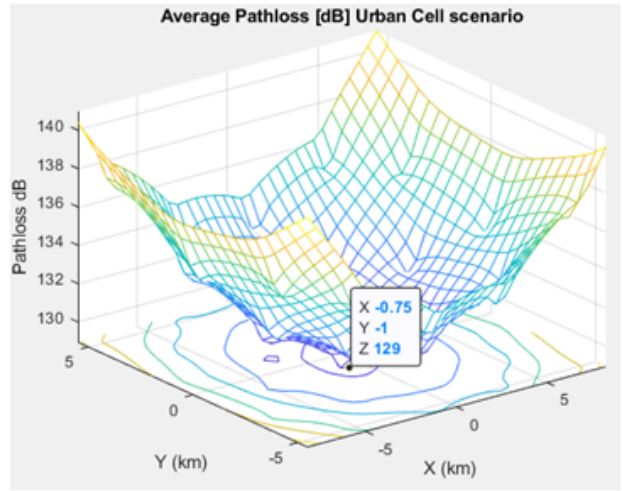
Figure 23. Average path loss in the urban scenario.